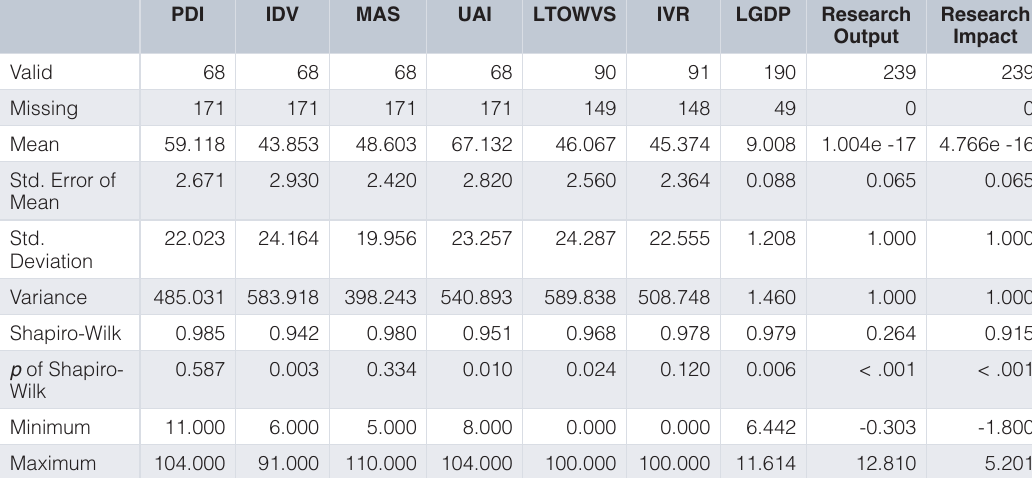
Table 5. Descriptive statistics of national cultural orientations, research output and impact.